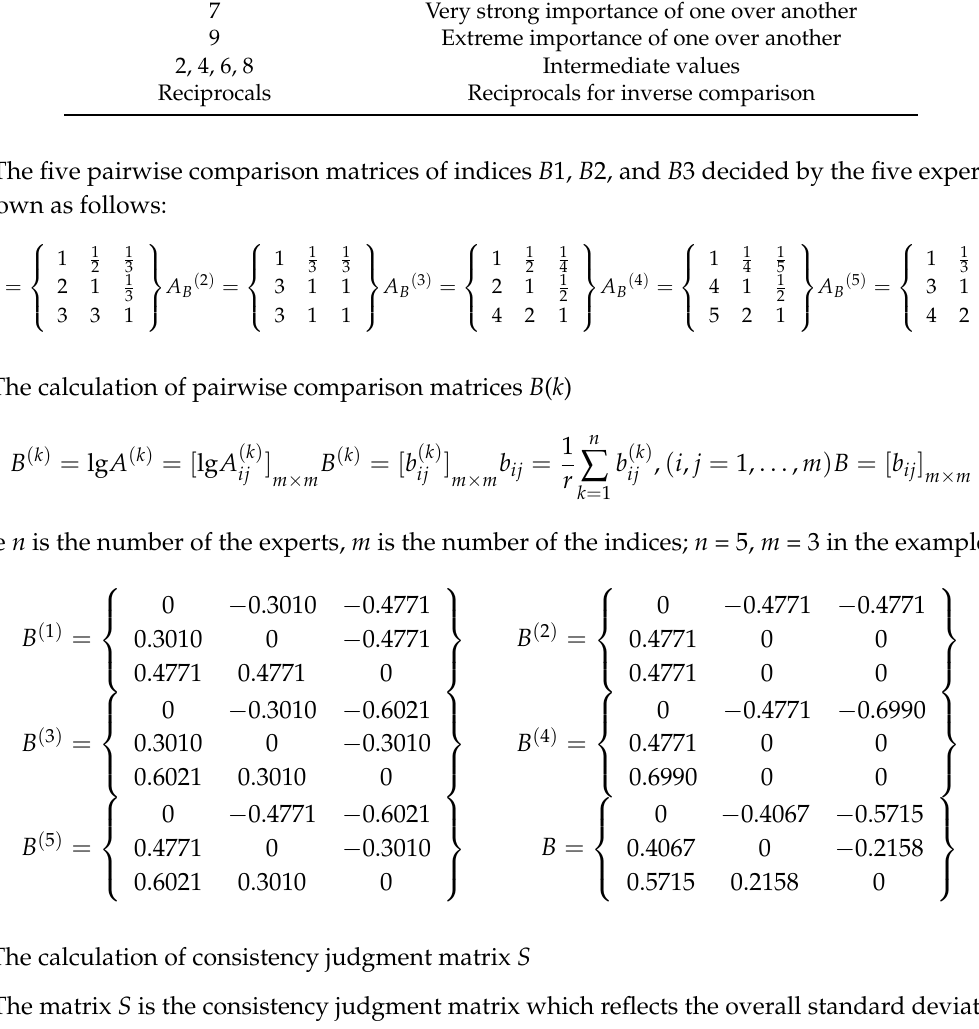
Table 2. The AHP scales (1–9) for pairwise comparisons. Experts’ Score Definition 1 Equal importance